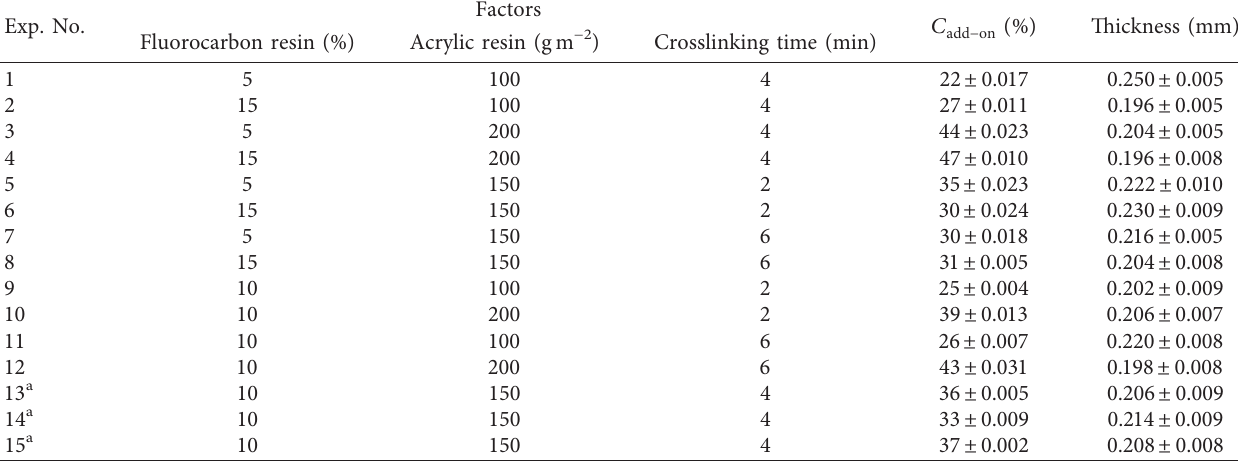
Table 2: C ( % ) and thickness (mm) values of the coated woven fabric samples. add − on